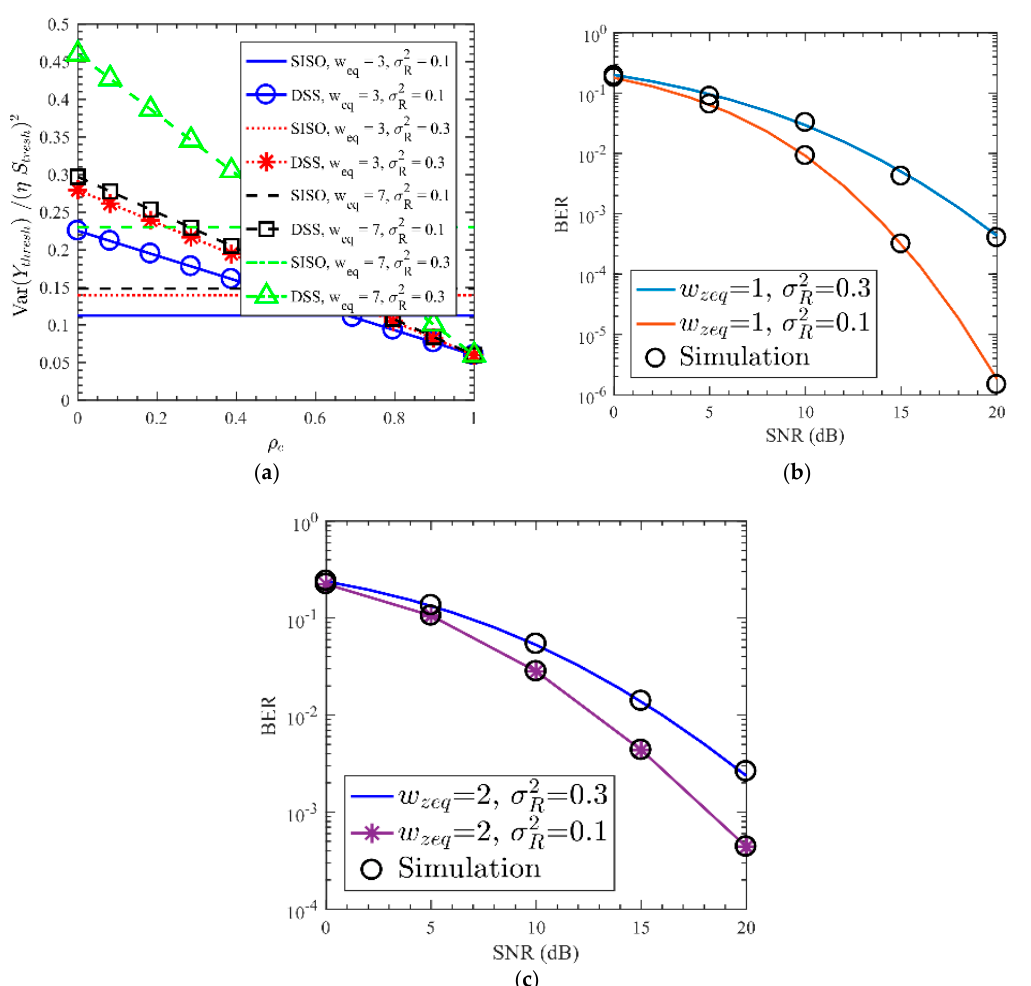
Figure 5. Single-input single-output (SISO) and differential signaling scheme (DSS) based free-space optical (FSO) links with pointing errors (PE) and weak turbulence: ( a ) the normalised variance of detection threshold level (DTL) versus the correlation coefficient of the channels; and ( b , c ) bit-error-rate (BER) against signal-to-noise ratio (SNR) for different values of w eq with unit of cm and σ 2 R